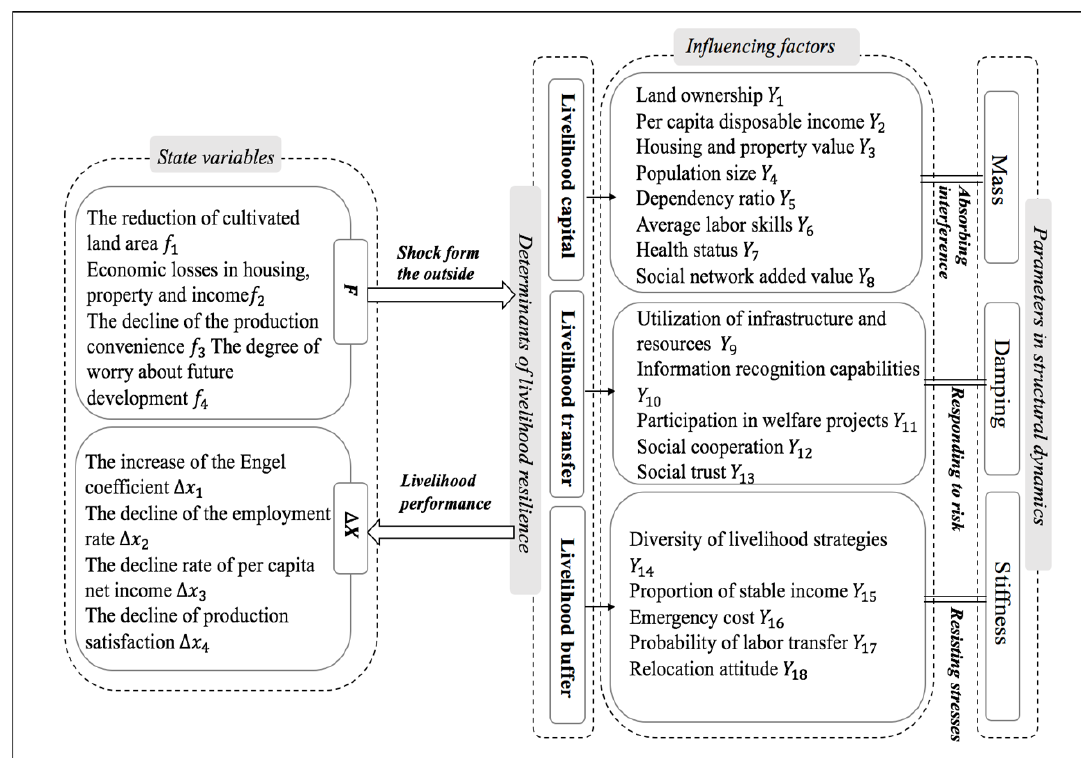
Figure 2. Livelihood resilience measurement framework. Source: designed by the authors. 296